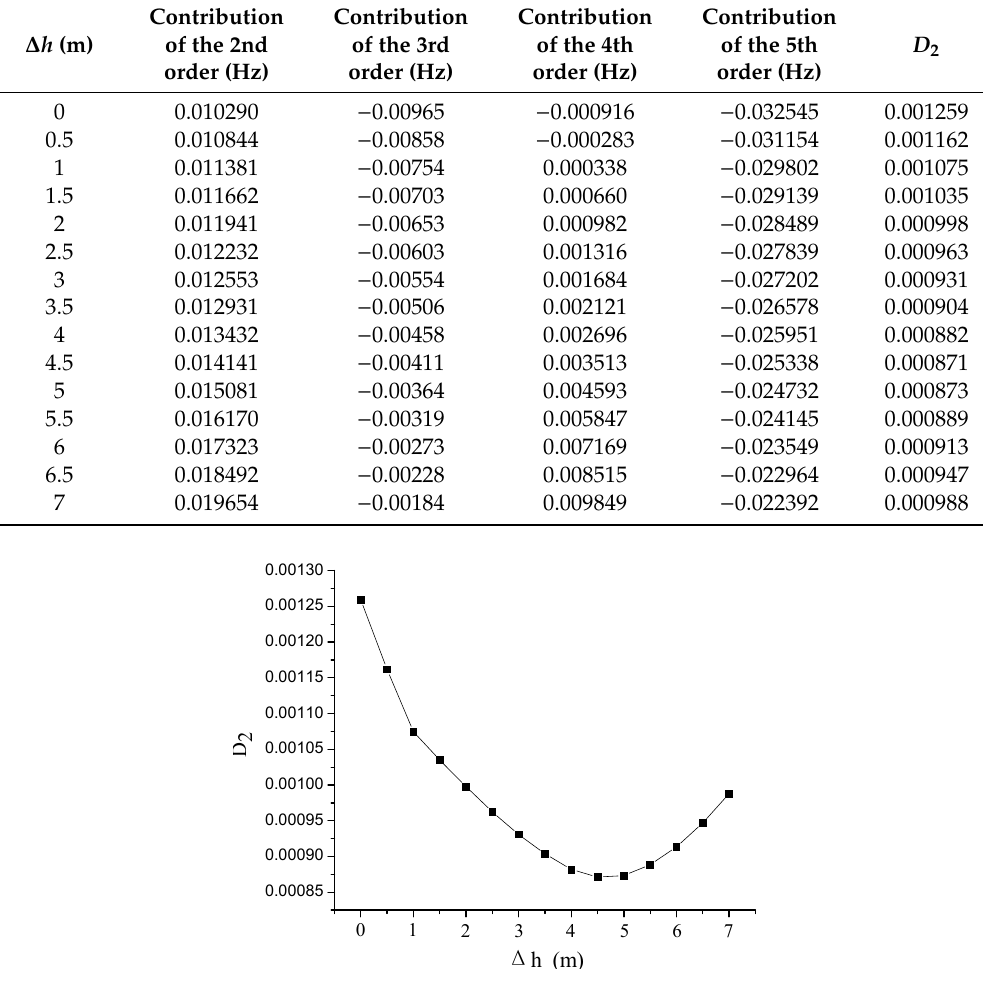
Table 8. Values of D 2 for di ff erent ∆ h .